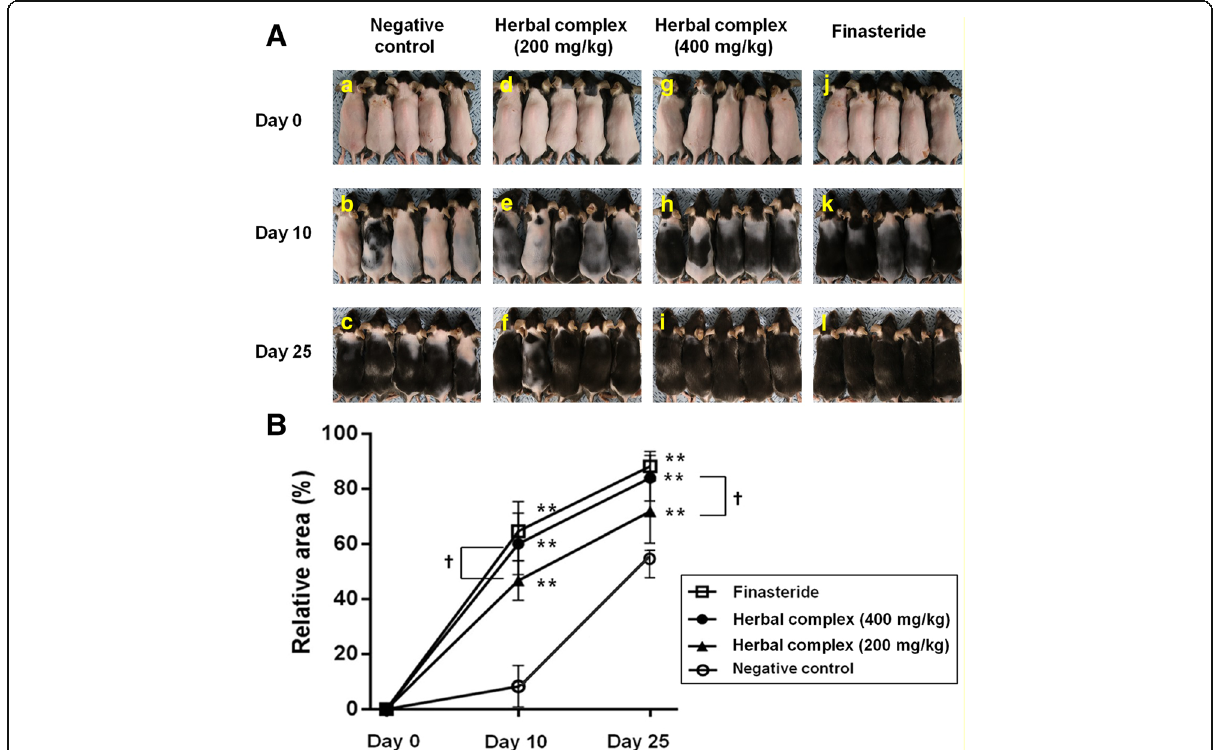
Fig. 2 Gross observation and measurement of the area of hair regrowth in C57BL/6 mice. a After the dorsal skin was shaved, each mouse were orally administered the distilled water (negative control group; A-C ), herbal complex=2:1:1200 mg/kg ( D-F ) or herbal complex=2:1:1400 mg/kg ( G-I ) group, and finasteride (1 mg/kg, as positive control group; J-L ) for 25 days. Herbal complex and finasteride were dissolved in 1.0 mL of distilled water and administered through an 8 F red Rob-Nel catheter once a day. Back skin was photographed at day 0, 10, and 25 after depilation. As the duration of treatment became prolonged, hair growth was more readily visible. The experimental group (both the 200 and 400 mg/kg groups) showed darker skin than the negative control group. b The area of hair regrowth by image software. Data are presented as the mean±SD. ** p < 0.001 compared with negative control, † p < 0.05 herbal complex 200 mg/kg vs. 400 mg/kg group. Herbal complex = Houttuynia cordata Thunb, Perilla frutescens Britton